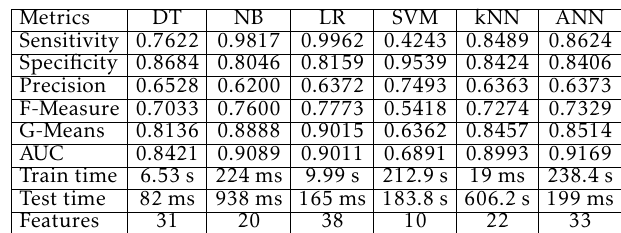
Table 29. Results of using CA-BFE algorithm on FUZZERS.